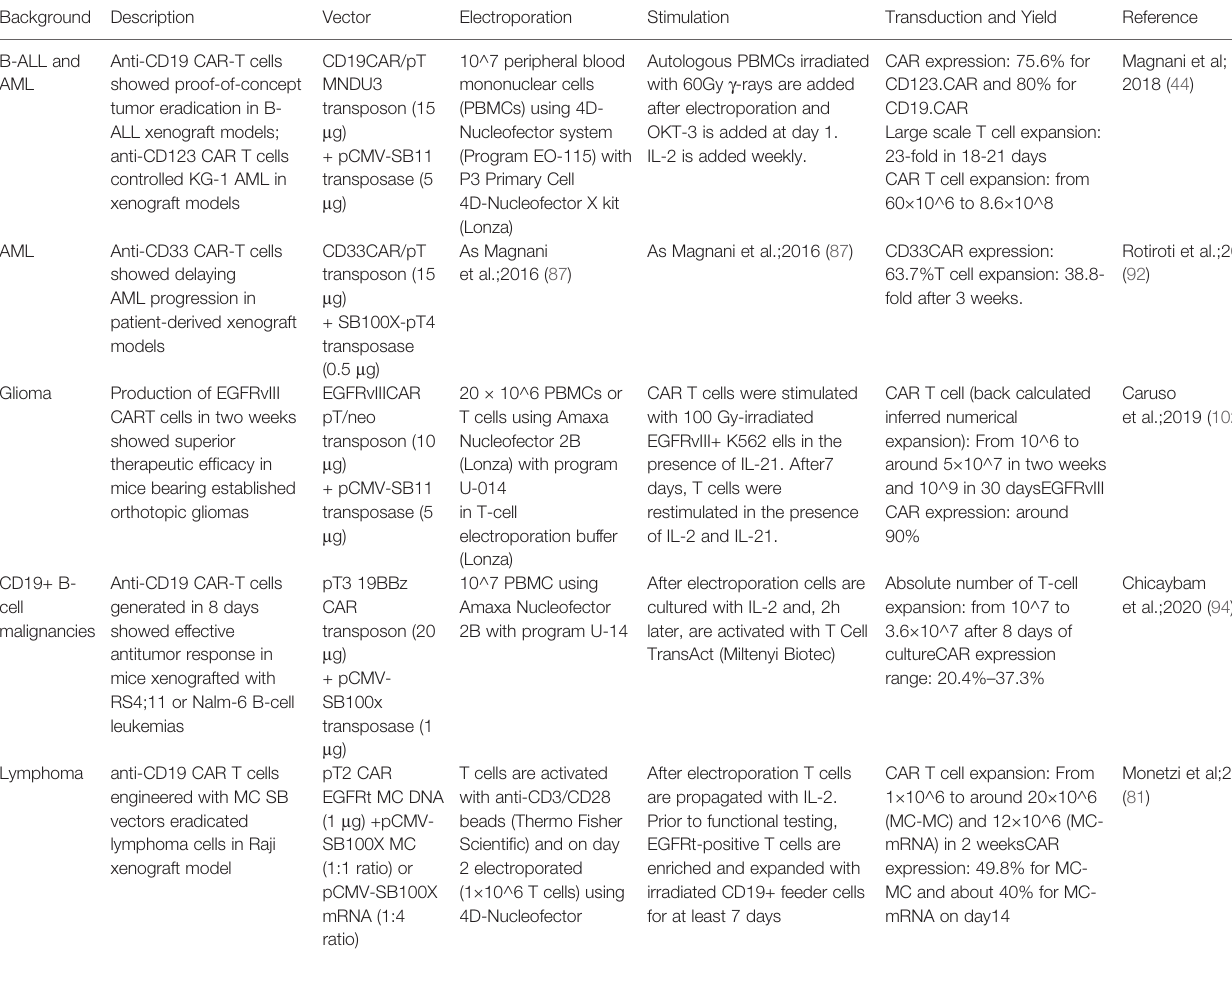
TABLE 2 | Manufacturing protocols associated with preclinical studies employing SB in the context of CAR T